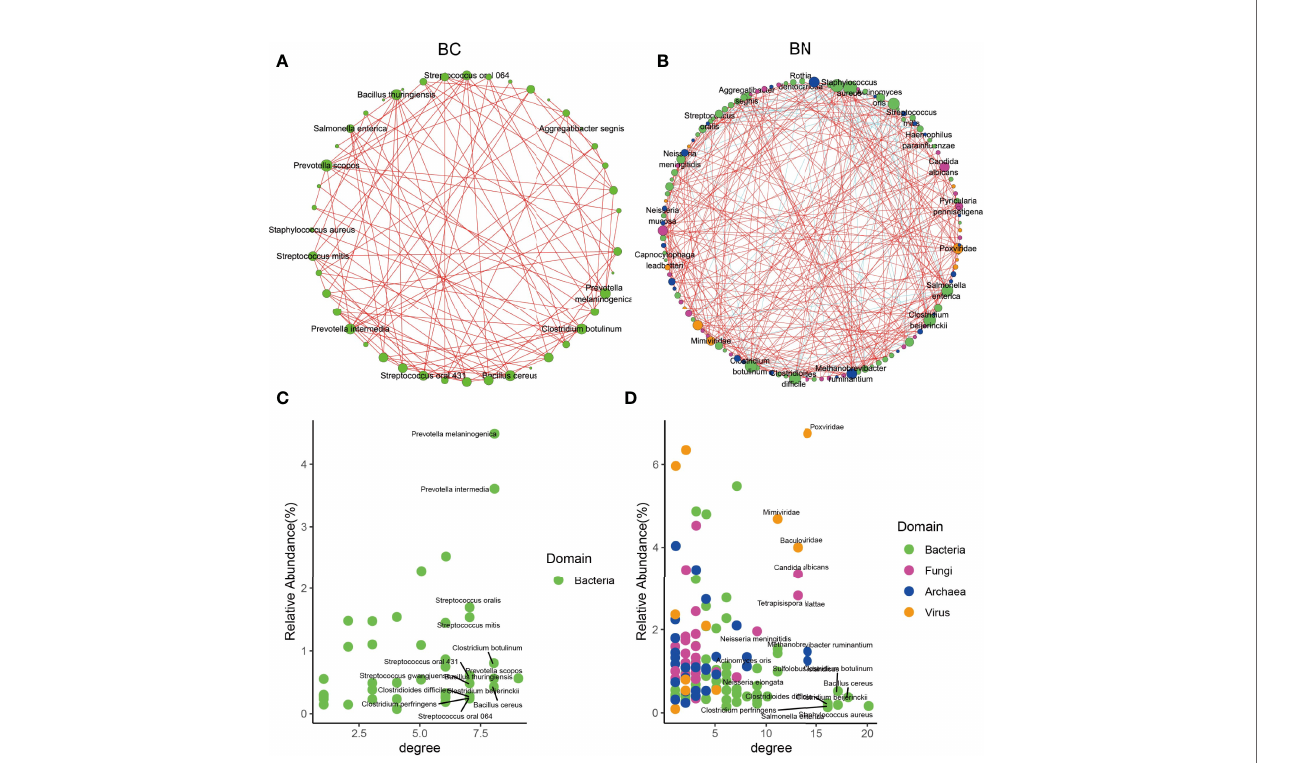
FIGURE 3 | Microbial interactions exhibited different state between BC and BN patients. Microbial interaction networks were calculated as the Spearman ’ s correlation of the relative abundance of the microbes and visualized using Cytoscape for the BC (A) and BN (B) patients respectively. Only those microbes with relative abundance more than 0.1% and presenting at least 50% of samples were included in the plots. The species with the highest average relative abundance and degree in the BC and BN networks are shown in (C, D)